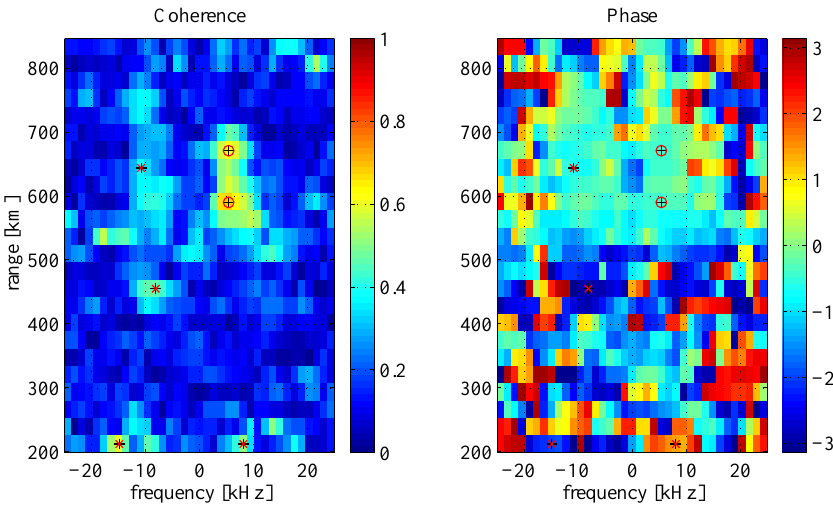
Fig. 11. An example of equal phase in both shoulders not captured by our technique, this is the 0 . 2s integration starting at 06:46:15.60 UT. The two panels show coherence and phase, and the points investigated by the search algorithm are marked with a red circle when accepted, and with a red x, otherwise.